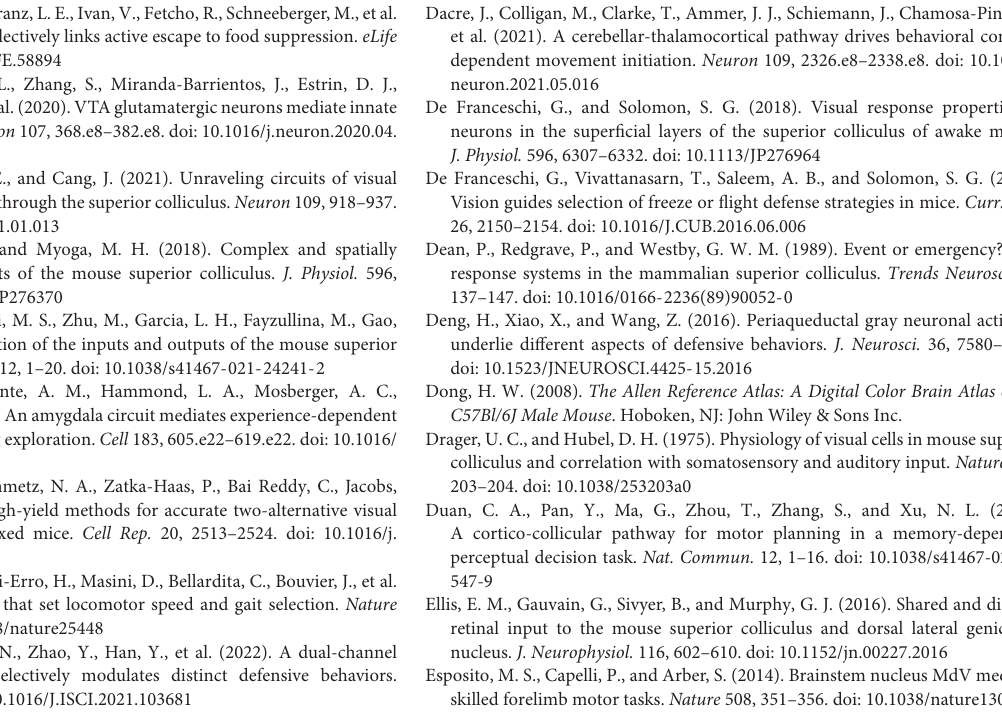
Figueroa-González,A.,etal.(2020).VTAglutamatergicneuronsmediateinnate defensive behaviors. Neuron 107, 368.e8–382.e8. doi: